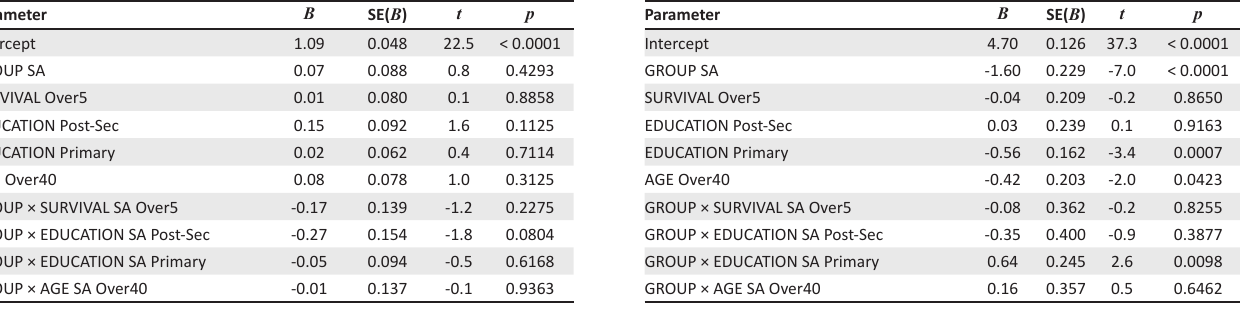
TABLE 8: Parameter estimates for two-way interaction analysis of variance model of use of discounting. Parameter